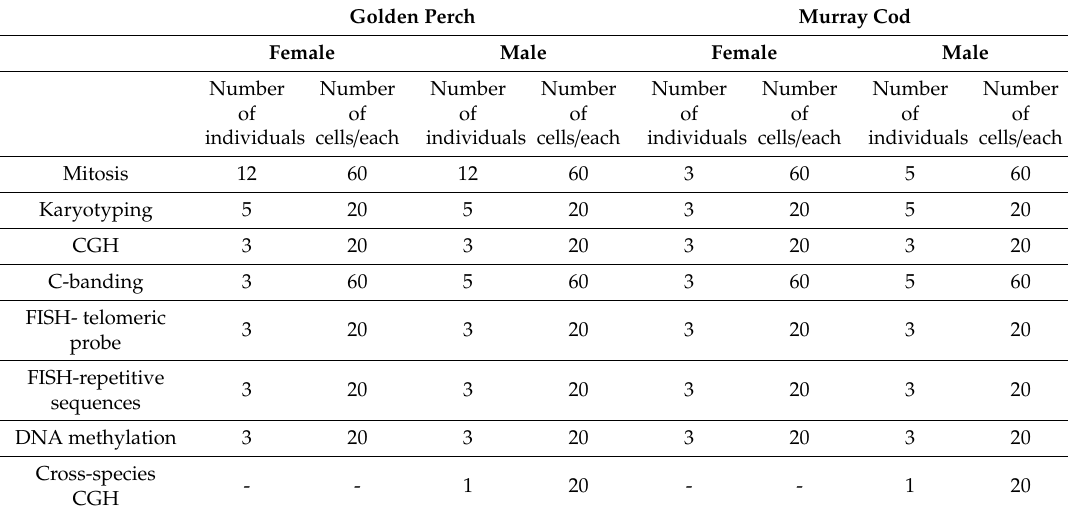
Table 1. Number of individuals and cells examined for the two fish species. The number of cells in the column for each group refers to the least number of mitotic chromosomes examined. CGH = Comparative Genomic Hybridisation; FISH = Florescence in situ